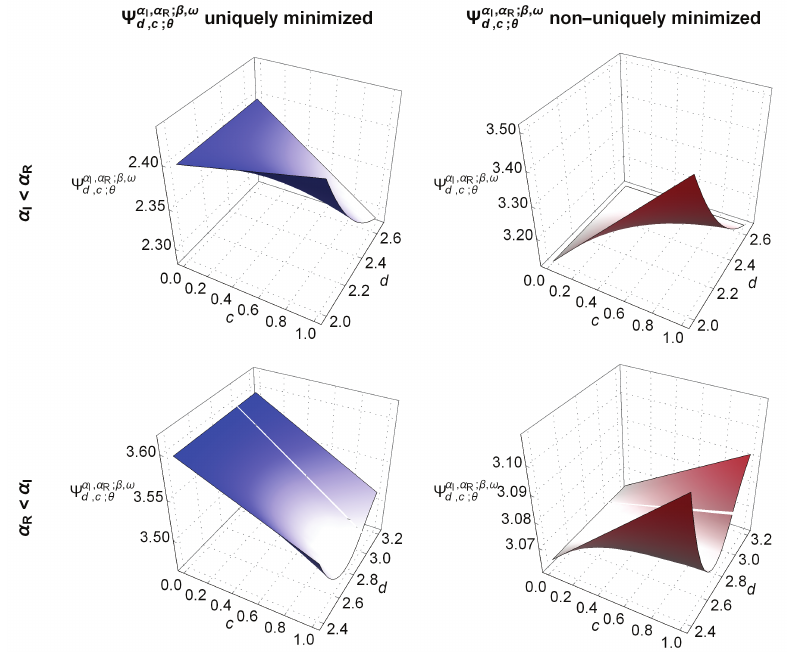
Figure 6. The surfaces of the objective function Ψ α I , α R ; β , ω when the initial loss X follows E ( 1 ) . They d , c ; θ are determined when α I (=0.05) < α R ( =0.07 ) (on the upper side) and when α R ( =0.03 ) < α I (=0.05) (on the lower side). On the left side, Ψ α I , α R ; β , ω is uniquely minimized. Meanwhile, Ψ α I , α R ; β , ω on the right d , c ; θ d , c ; θ side non-uniquely attains its minimum.